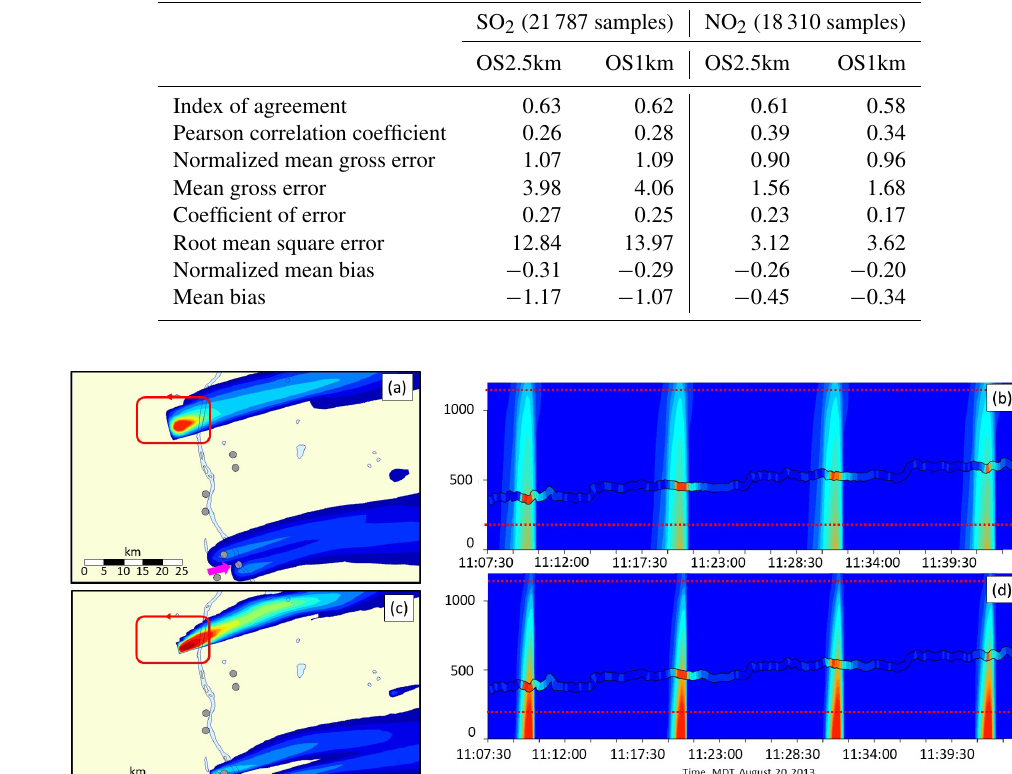
Table 6. Aircraft observation comparisons, SO 2 and NO 2 (ppbv).